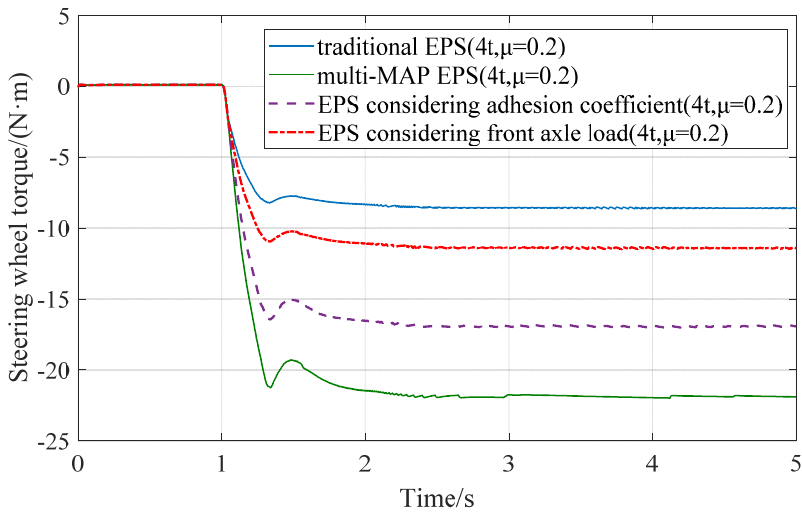
Figure 9. Comparison of steering wheel torque of different EPS system.